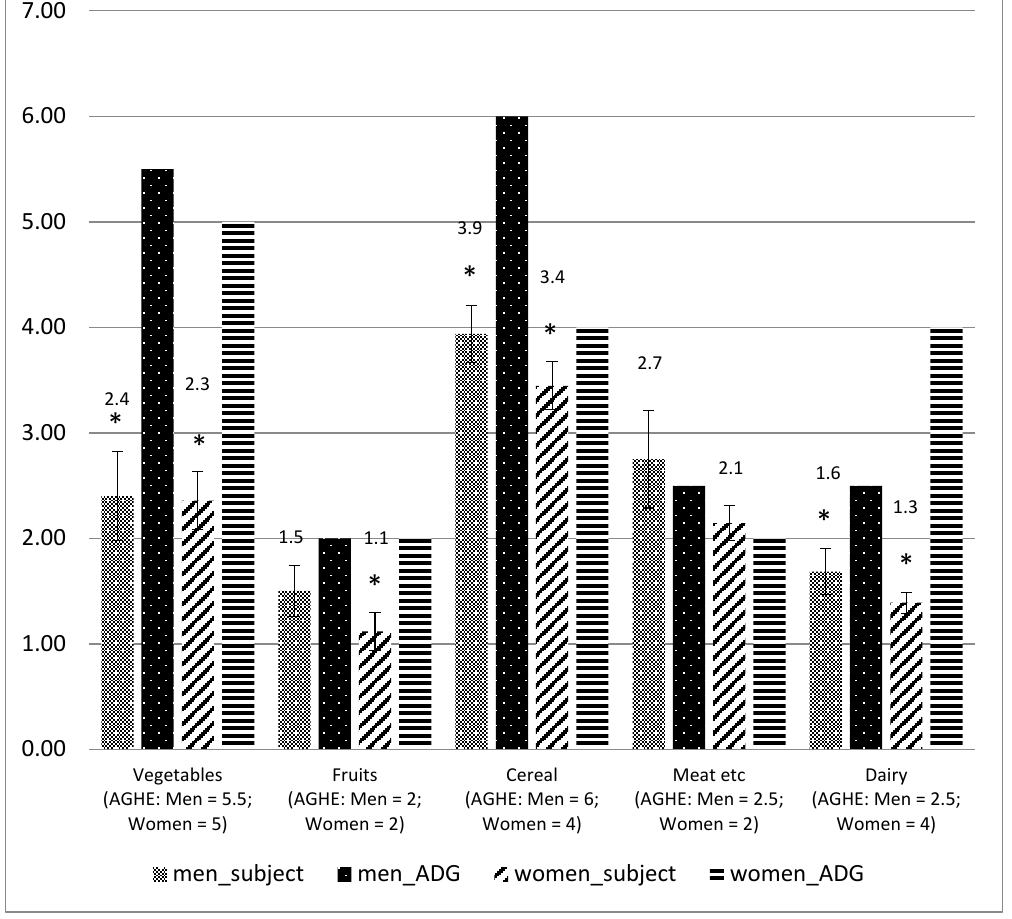
Figure 1. Serves of core food groups among men and women with ID, compared to the Australian Guide to Healthy Eating [50]. * p < 0.05 (one sample t -test).